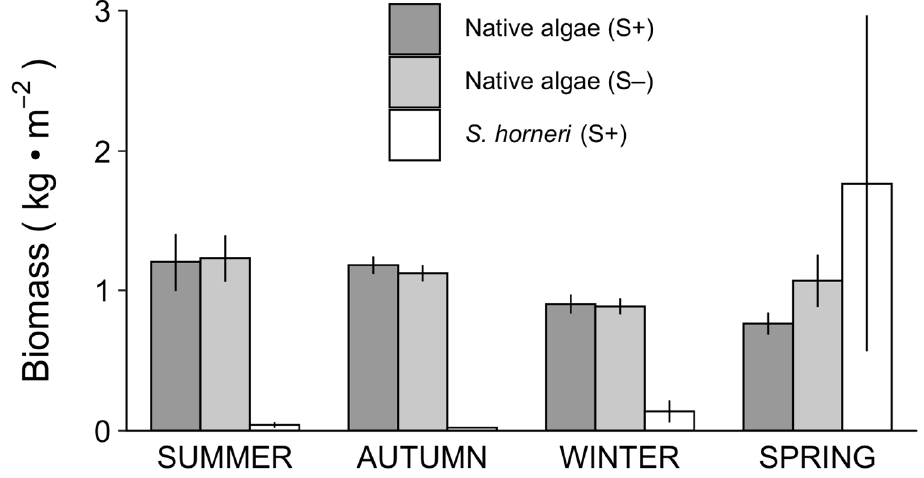
Figure 5. Seasonal mean (± SE) damp biomass of native algae (all species combined) and Sargassum horneri in S. horneri- removal (S − ) and non-removal (S+) plots. N = 4 years for summer, and 3 years for autumn, winter and spring.